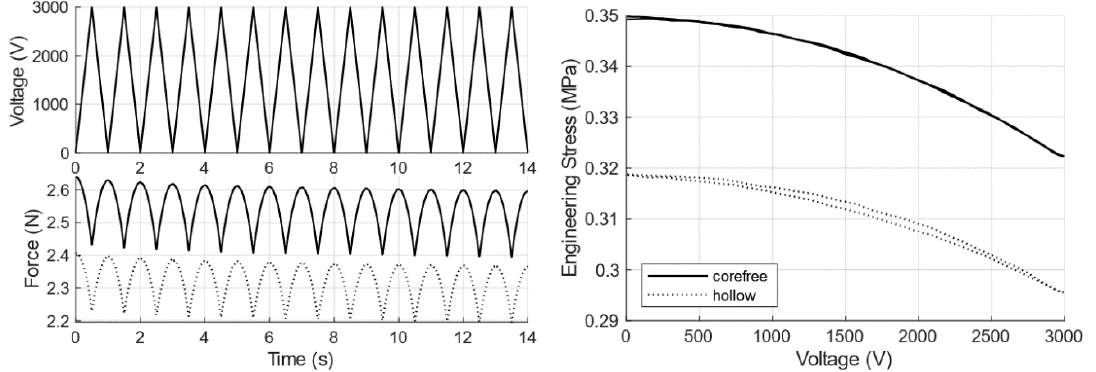
Figure 14. Blocking force measurements of both RDEAs. Raw data on the left, normalized data for the last cycle on the right.